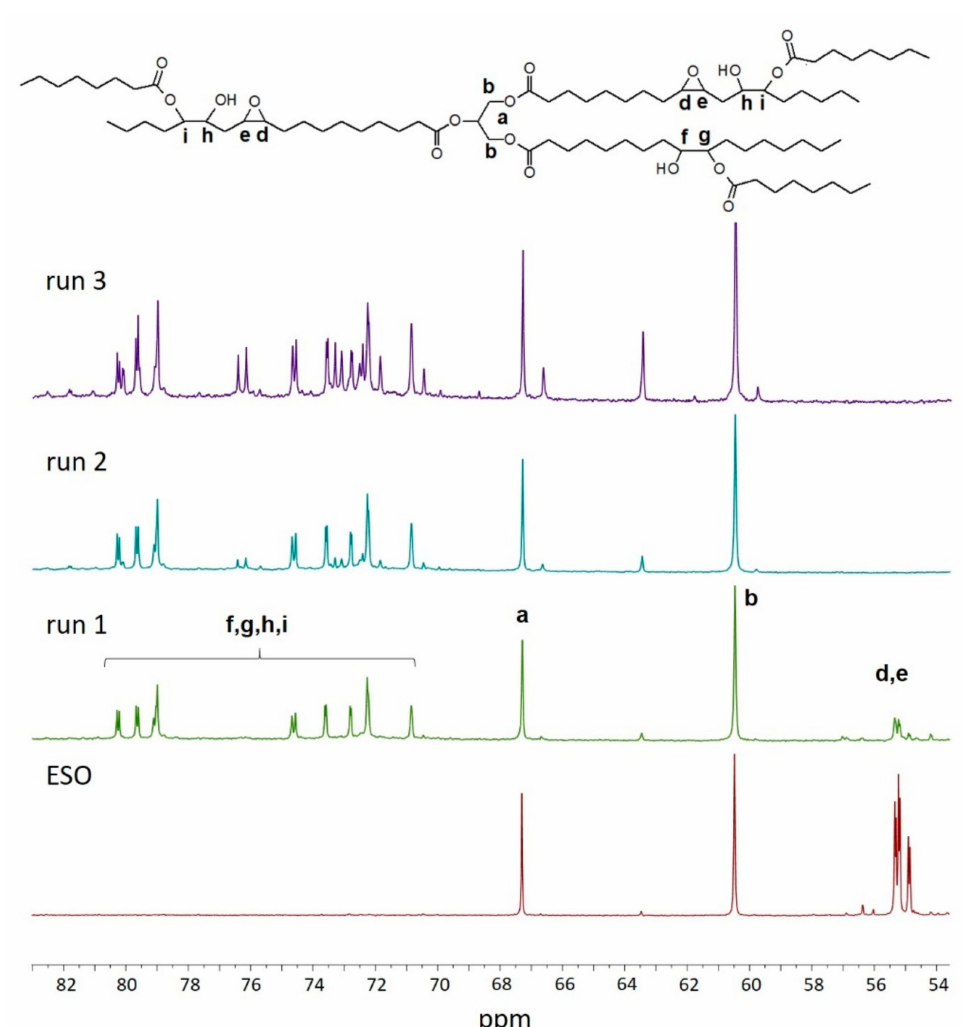
Figure 1. 13 C-NMR spectrum of bio-polyol from ESO (epoxidized soybean oil) and caprylic acid obtained at different epoxy/carboxyl molar ratios. Signals are normalized in respect to signals at 67.3 and 60.5 ppm (methylene and methine carbon atoms of